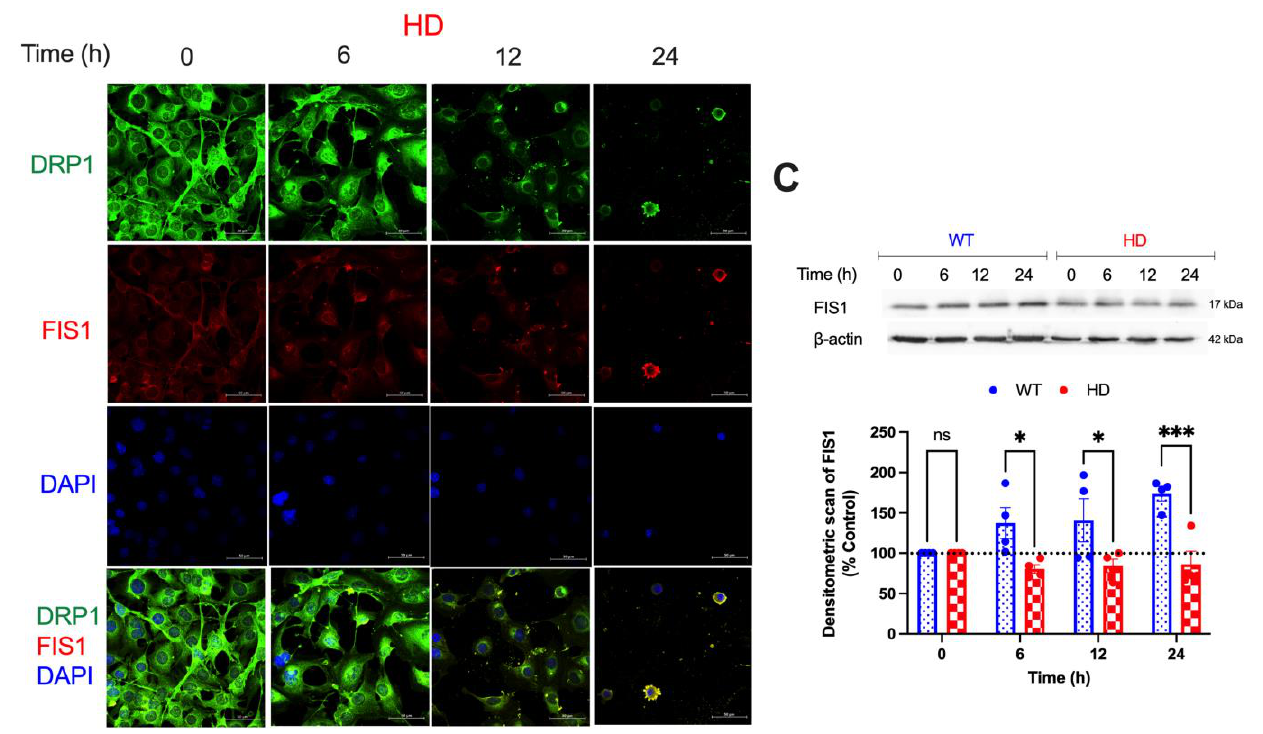
Figure 3. Effect of Cd exposure on the expression of mitochondrial fission proteins in WT and HD striatal cells. ( A ) Representative confocal images show the effect of 40 µM CdCl 2 exposure on the expression of DRP1 (green) and FIS1 (red) co-stained with DAPI (blue) upon 0, 6, 12, and 24 h exposures. Scale bar: 50 µm. ( B ) Western blot analysis of DRP1 and ( C) FIS1 protein expression. Quantitative immunoblotting data is represented as percent expression relative to the respective control within each genotype. Representative images of Western blot analysis are shown. Results are represented by the mean ± SEM from four to nine biological replicates (N = 4 – 9). ns indicates no significant difference between genotypes at the indicated exposure time. Sidak’s multiple comparison test compared the effect of Cd on endogenous DRP1 and FIS1 expression between genotypes at the indicated time points (significant differences: * p < 0.05 and *** p < 0.001, Student’s t -test). Sidak’s multiple comparison test compared all treatments back to the vehicle for each genotype. Images at 63 ×